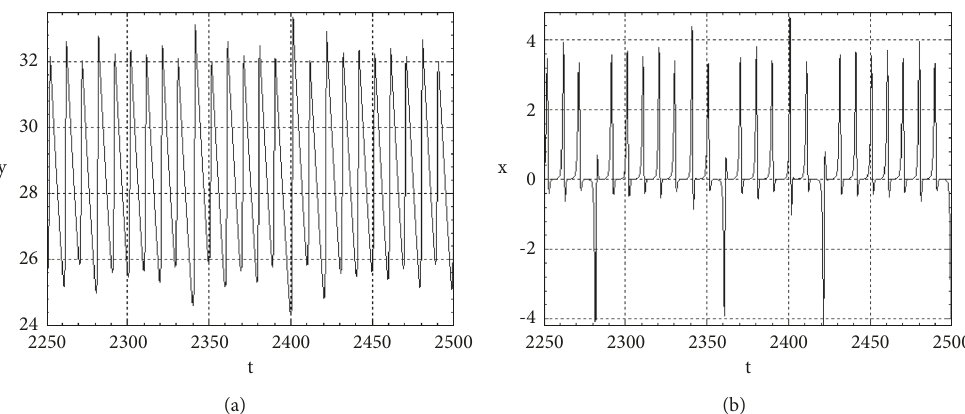
Figure 10: The time series of system (4a–4c) for specific value of σ parameter. The other parameters are c � 30; u � 0.009; β � 0.03; v � 0.005; T 3 � 0.01; initial conditions are (0.01, 0.01, 20).